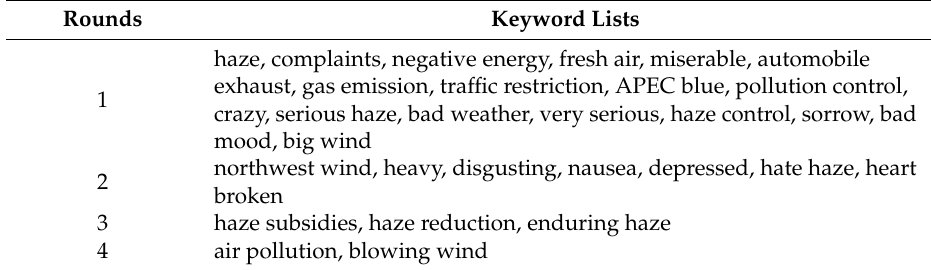
Table 2. The lists of keywords for addition in the four rounds of corpus analysis.